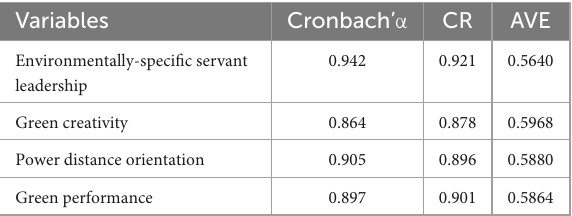
TABLE 2 Reliability and validity analysis.